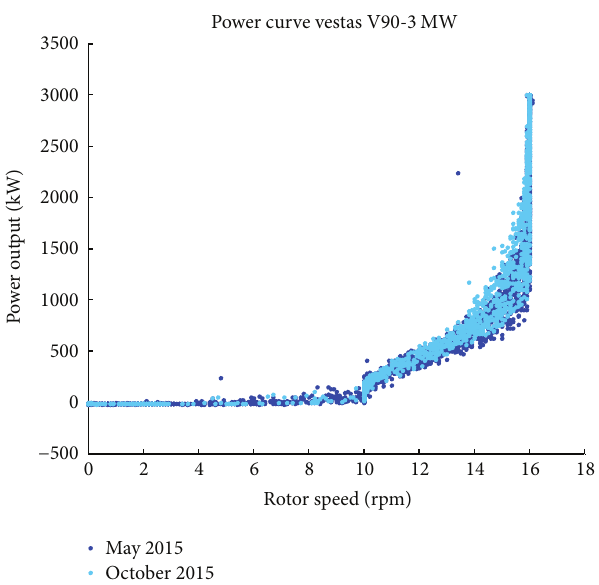
Figure 14: Scatter plot with power output as function of the rotor speed.